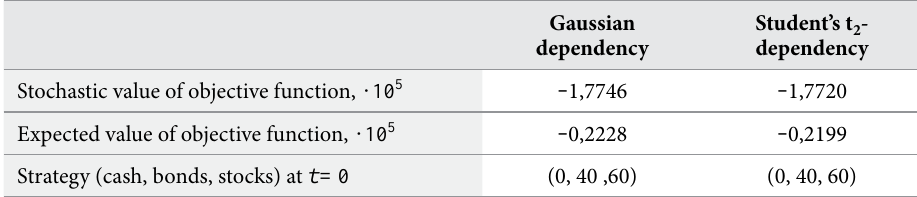
Table 6. The optimal values under different dependency structures with catastrophe